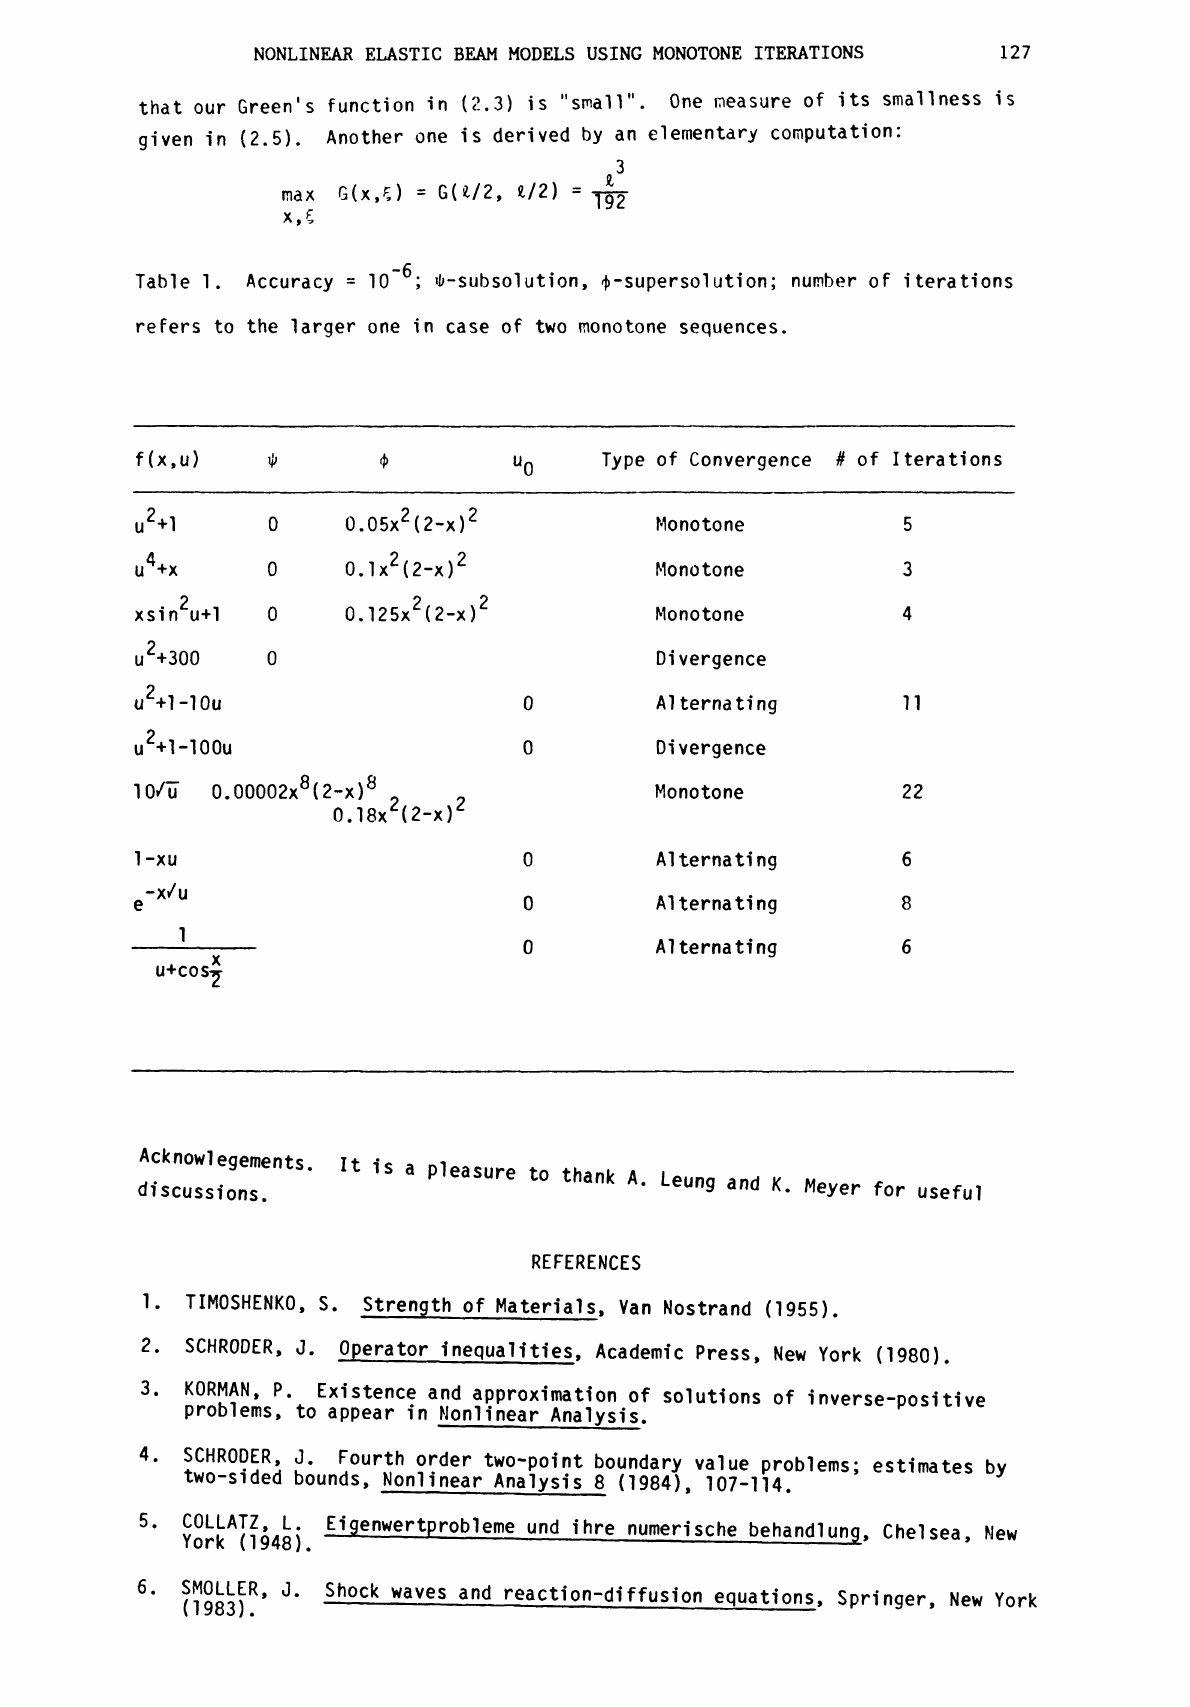
-6" ,-subsolution, -supersolution; number of iterations Table I. Accuracy lO refers to the larger one in case of two monotone